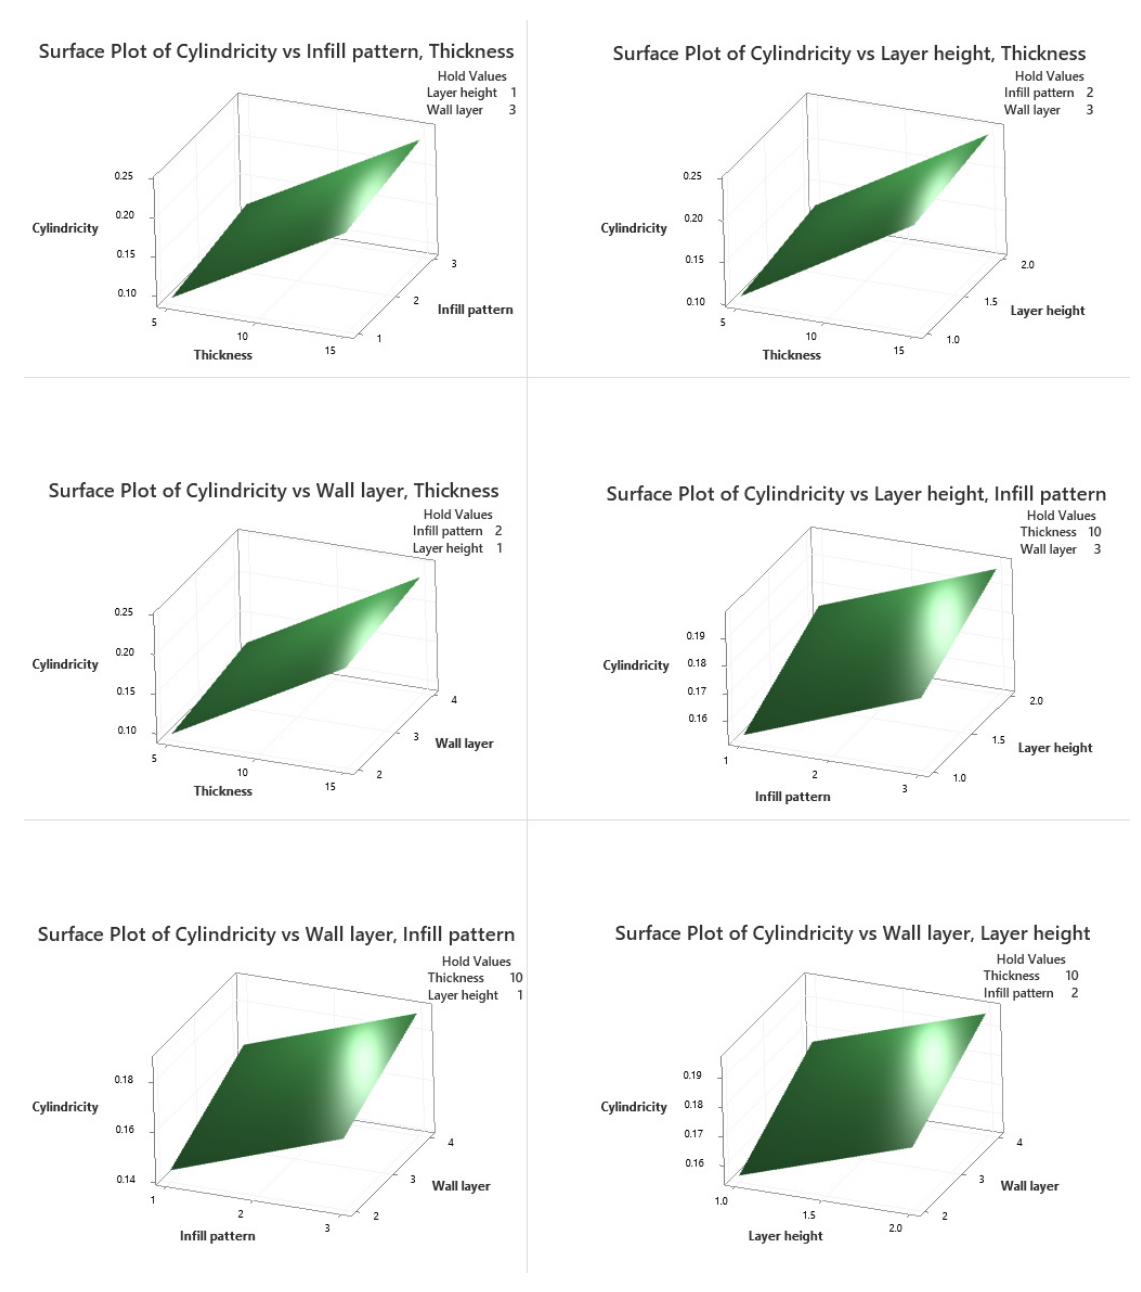
Figure 6. Cylindricity surface plots.